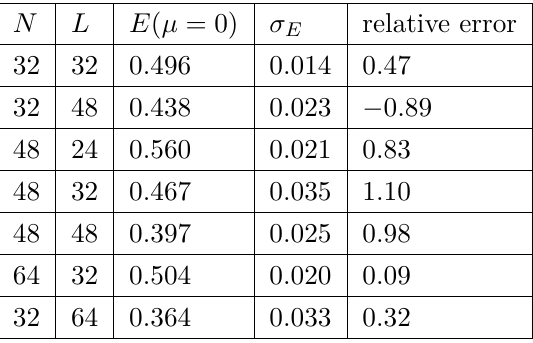
Table 5 . Simulation results for T = 0 . 3 , µ = 0 are summarized. We also present the relative error to the simulation results at µ = 0 . 5 as follows: we use the ansatz (5.2) with the coefficients from table 2 to estimate the energy E ( µ = 0 . 5) at a given N , L and correct for the finite µ correction using equation (3.24), which amounts to subtracting 0 . 0076 to get the µ = 0 value as opposed to µ = 0 . 5 . We then subtract the BFSS measurement E ( µ = 0) and divide by its ( 1 σ ) statistical error σ E .